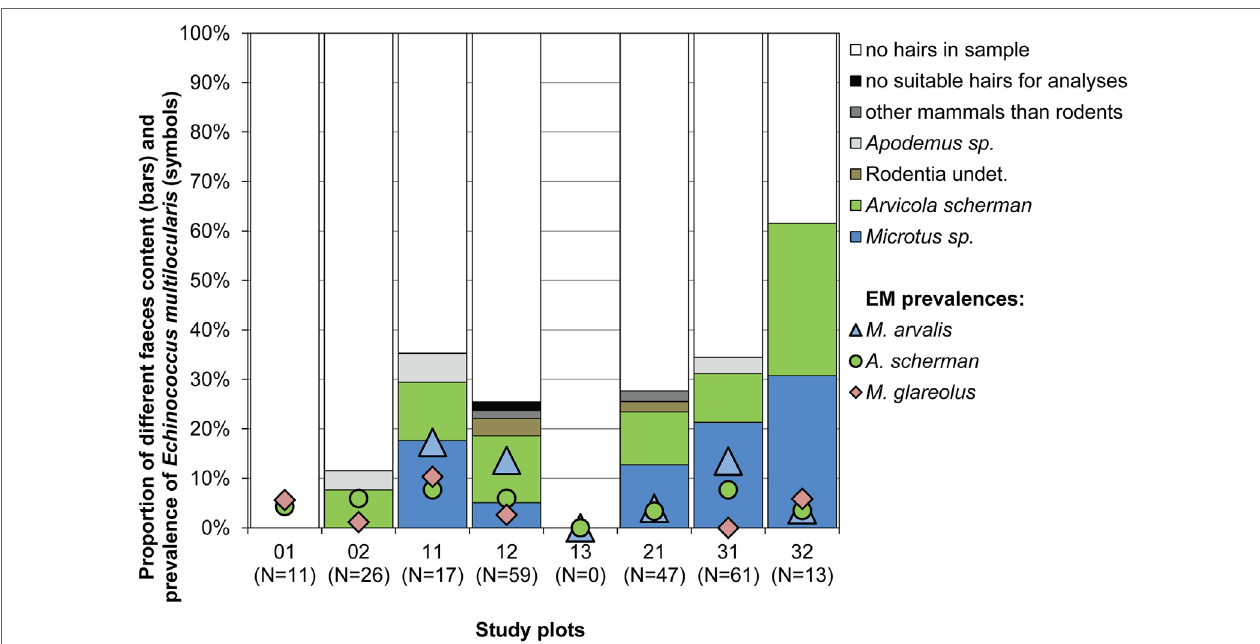
FigUre 4 | Proportion of different species determined by hair analyses of samples from 234 fox droppings (4–7 g per dropping) collected from spring 2014 until spring 2015 (bars) and percentages of E. multilocularis -infected voles per study plot and species during the whole study period (symbols). No Myodes sp. hairs were detected. No fecal analyses have been done for plot